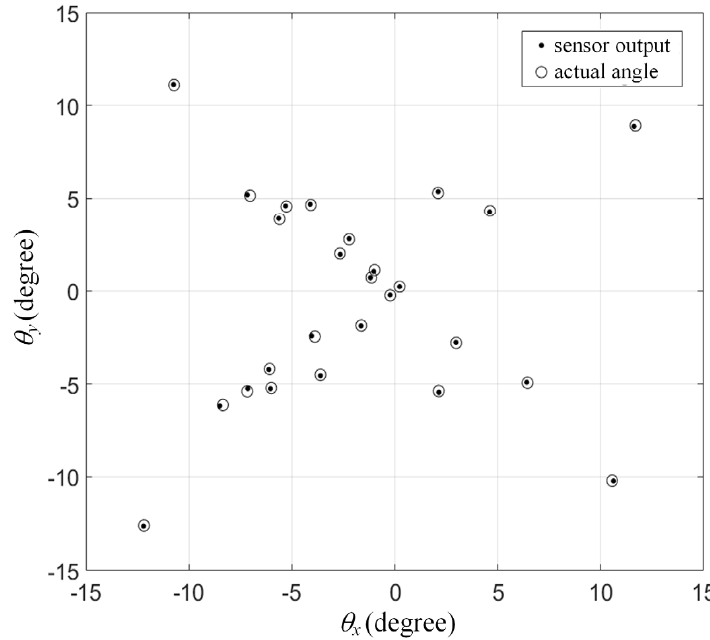
Figure 10. The flow chart for testing the proposed sensor.